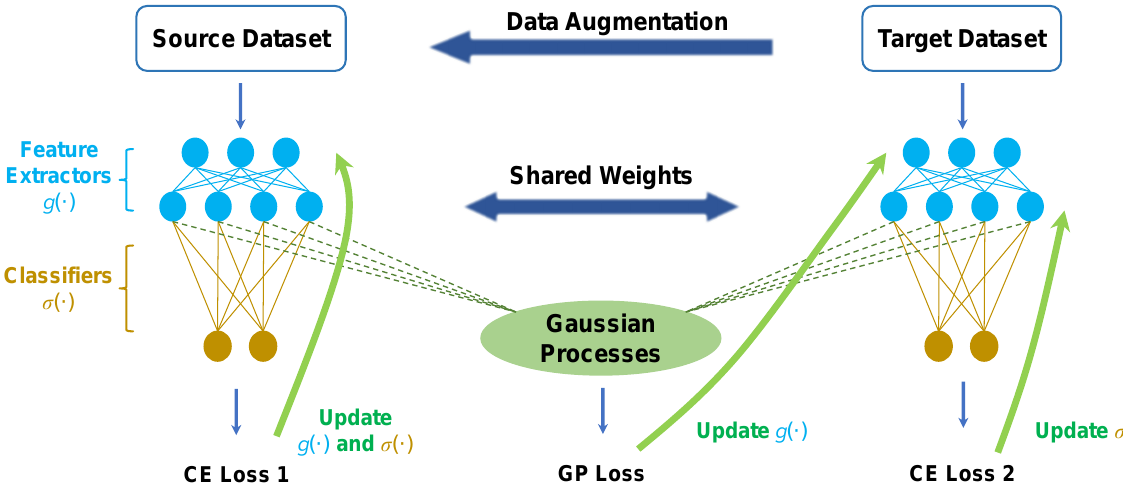
Figure 2. Framework of the GPGDA algorithm. All parameters of the network were pre-trained on the source dataset first. Then, the difference between the distribution of features learned from the source dataset and the training dataset (target dataset) was measured via the Gaussian processes, and the parameters of feature extractors were updated based on this information. In addition, the information of training dataset labels was adopted to update the parameters of the classifier individually. CE Loss: cross entropy loss; GP Loss: the difference measured by